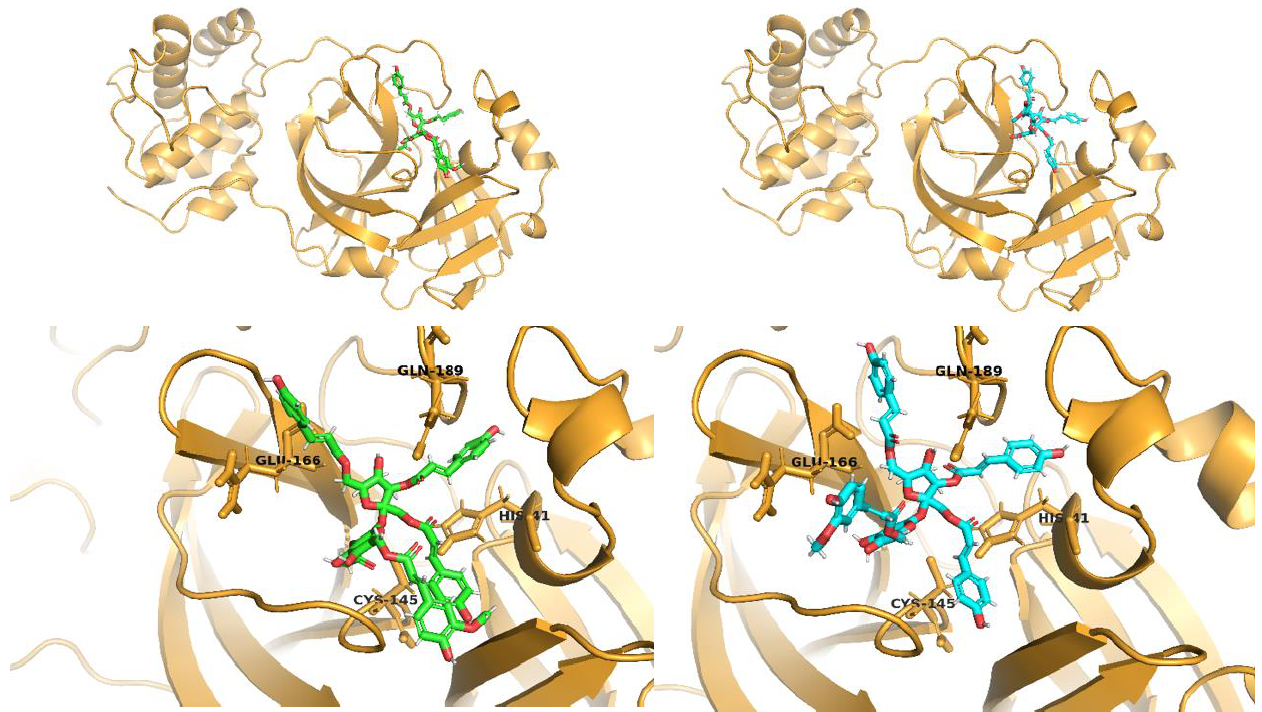
Figure 3. 3D visualization of best scored compounds: Vanicoside A (images on the left — green), Vanicoside B (images on the right — cyan).